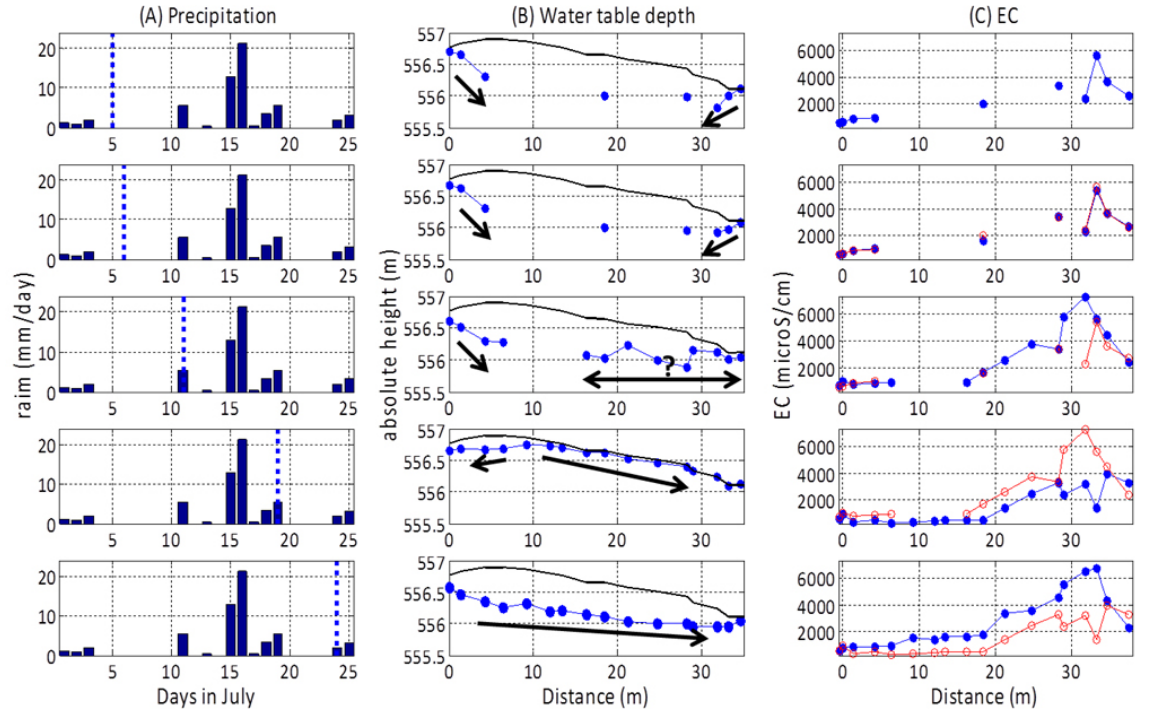
Fig. 9. Measured precipitation (A) ; water table depth (B) ; and EC (C) along the 107–108A transect. The dashed lines in (A) indicate the day on which measurements were taken for (A) , (B) , and (C) in the same row. In (B) the black line is the ground surface and the blue curve is the location of the water table. Arrows indicate groundwater flow directions. In (C) blue lines indicate the measured EC along the transect. Red curves are measured EC for the previous measurement, to emphasize the change of EC with